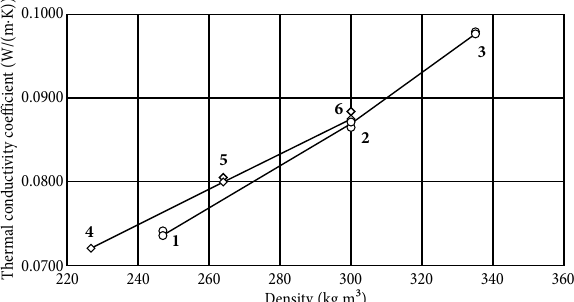
Fig. 6. Influence of the amount of PC on density and thermal conductivity coefficient of LWAC samples of